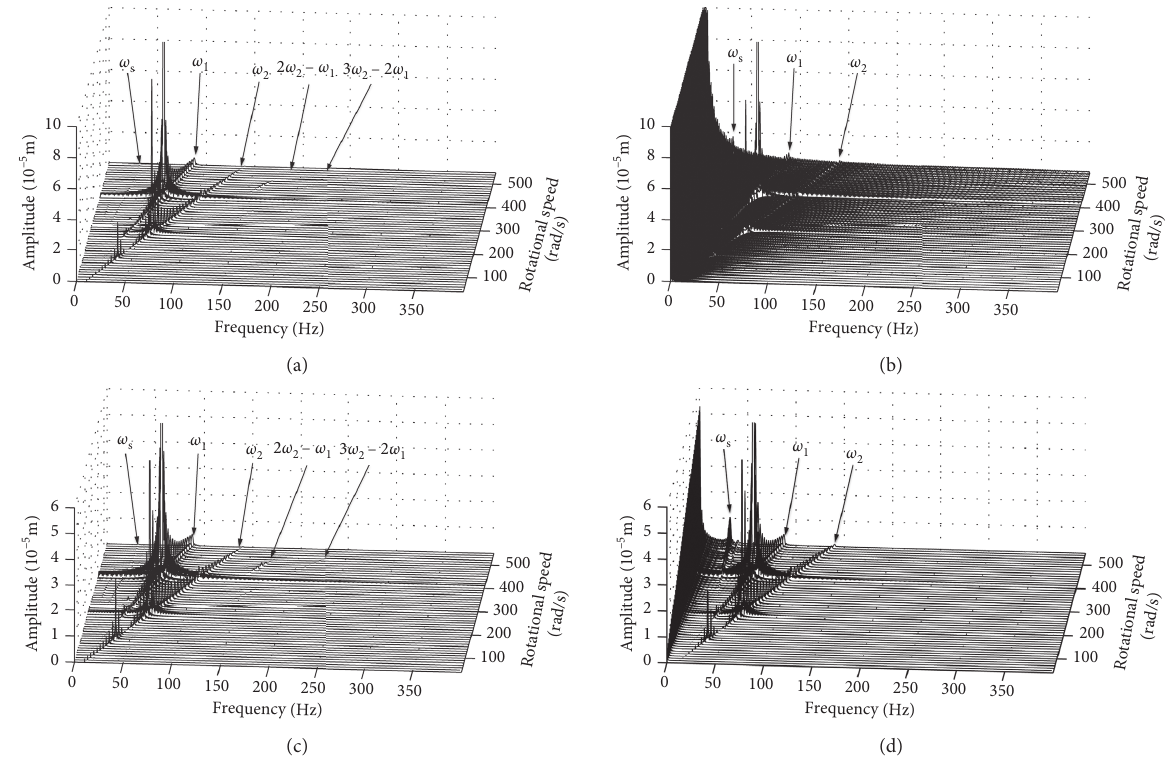
Figure 13: Waterfall spectra plots for the vibration of disk 3. (a) Horizontal response, straight flight. (b) Horizontal response, hovering. (c) Vertical response, straight flight. (d) Vertical response,